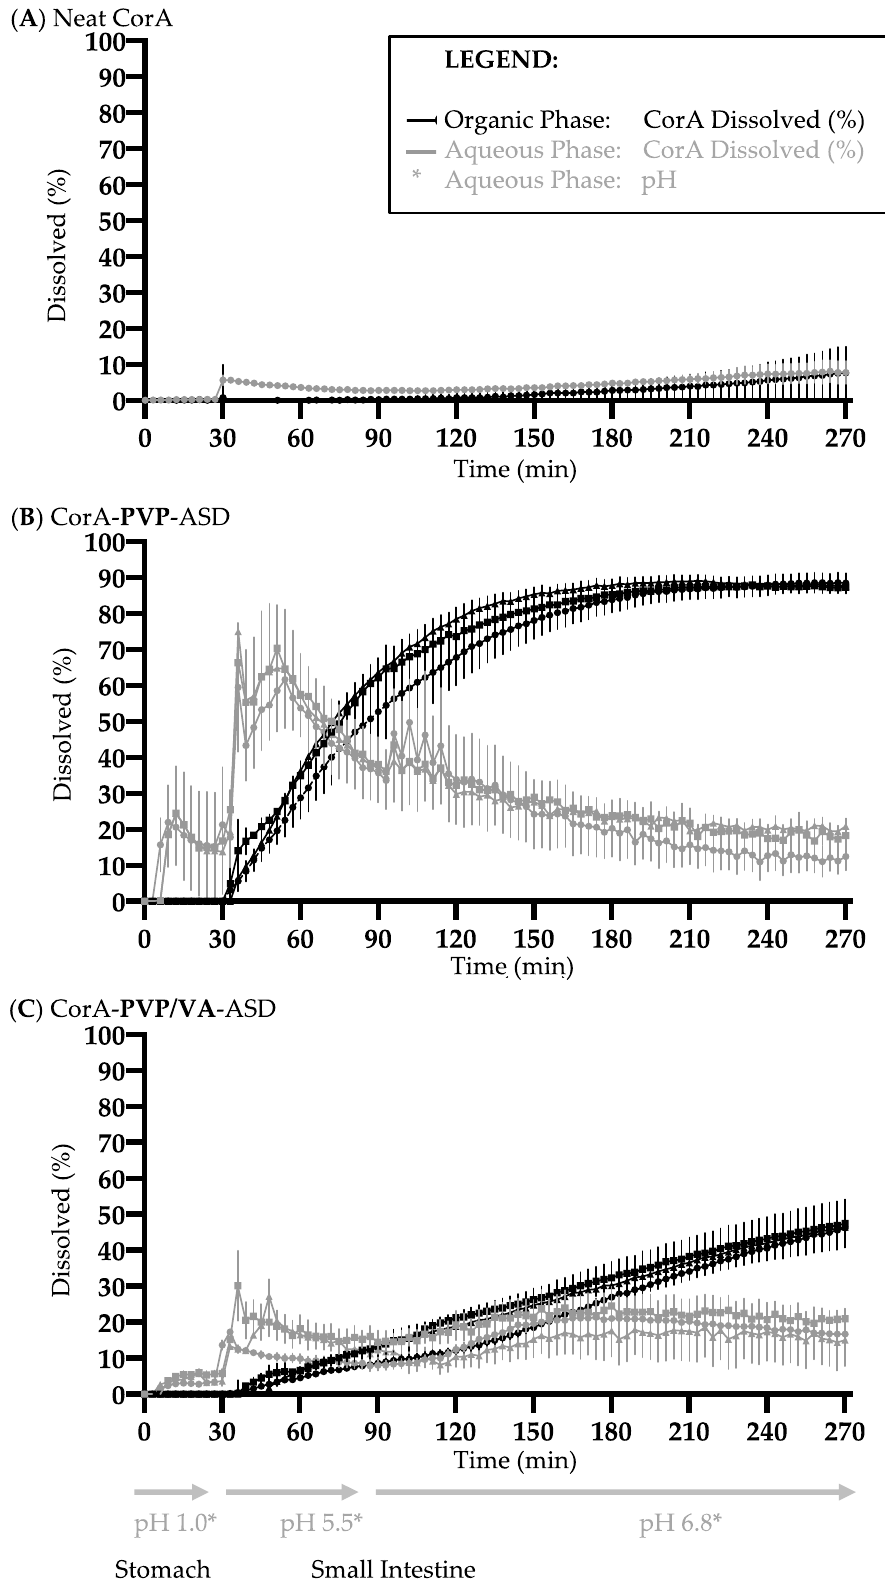
Figure7. BiphasicdissolutionprofilesofneatCorA( A ),spray-driedCorA-PVP-ASDformulation( B )and Figure 7. Biphasic dissolution profiles of neat CorA ( A ), spray-dried CorA-PVP-ASD formulation ( B ) spray-dried CorA-PVP / VA-ASD formulation ( C ). Start sample (symbol = circle), four-week stability and spray-dried CorA-PVP/VA-ASD formulation ( C ). Start sample (symbol = circle), four-week sample 25 ◦ C / 60% RH (symbol = square), four-week stability sample 40 ◦ C / 75% RH (symbol = stability sample 25 °C/60% RH (symbol = square), four-week stability sample 40 °C/75% RH (symbol = triangle).